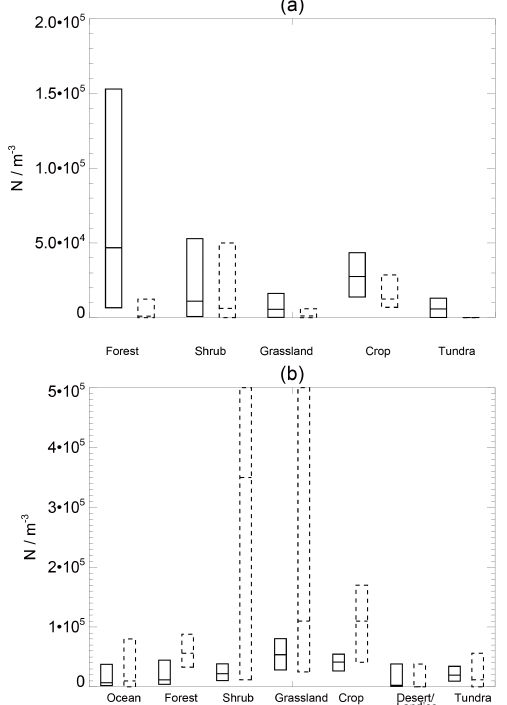
Figure 2. Comparison of simulated (solid) and observed (dashed) surface (a) fungal spore and (b) bacteria number concentrations across different ecosystems. Boxes show minimum, mean and max- imum concentrations. Observed concentrations are a synthesis of fungal spore (Sesartic and Dallafior, 2011) and total bacteria (Bur- rows et al., 2009a) number concentrartions in near-surface air. The observed maximum for shrub and grasslands is 8 . 4 × 10 4 m − 3 and extends off the scale. Simulated concentrations are the mean, max- imum and minimum annual mean surface concentrations for that ecosystem